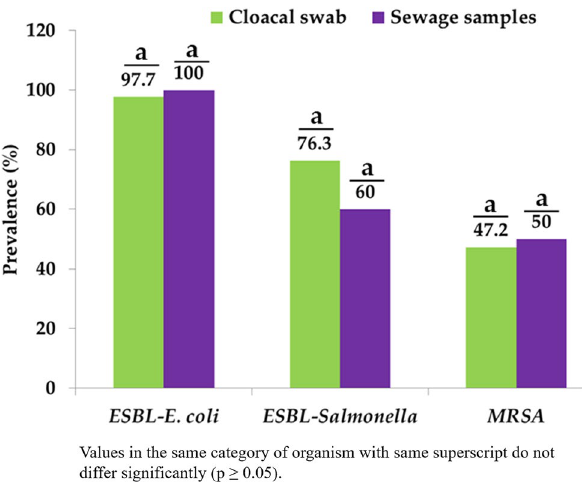
Figure 3. Prevalence of ESBL-producing E. coli and Salmonella spp., and methicillin-resistant S. aureus (MRSA) isolated from cloacal swab and sewage